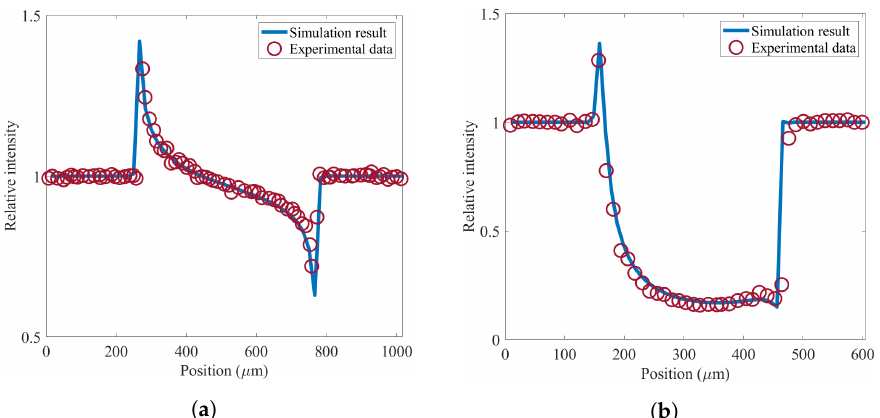
Figure 4. Comparison between the simulation result and experimental data extracted from [25] for ( a ) a PEEK wire, and ( b ) a Titanium wire. The solid blue line represents the simulation result, and the red circles demonstrate experimental data.